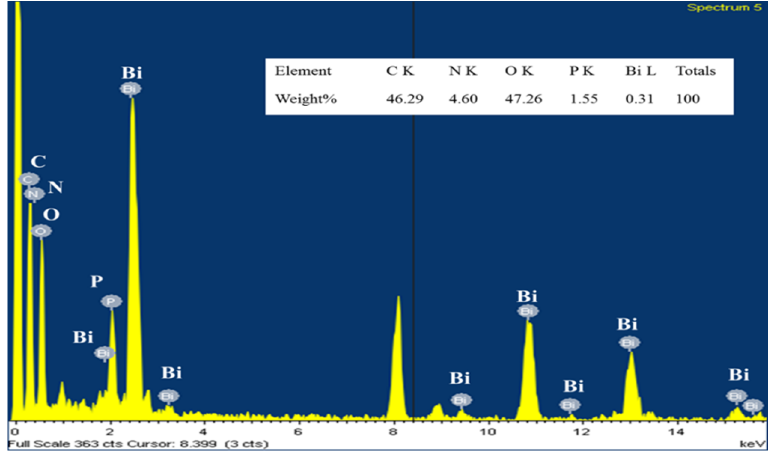
Figure 4. EDX spectrum of the 5 wt.% PPy/BiPO 4 composites.